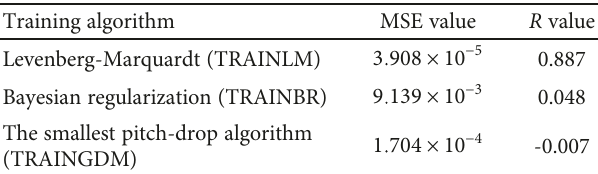
Table 9: Values of MSE and R depending on the training algorithms (for two neurons in the hidden layer) in model ANN 3.